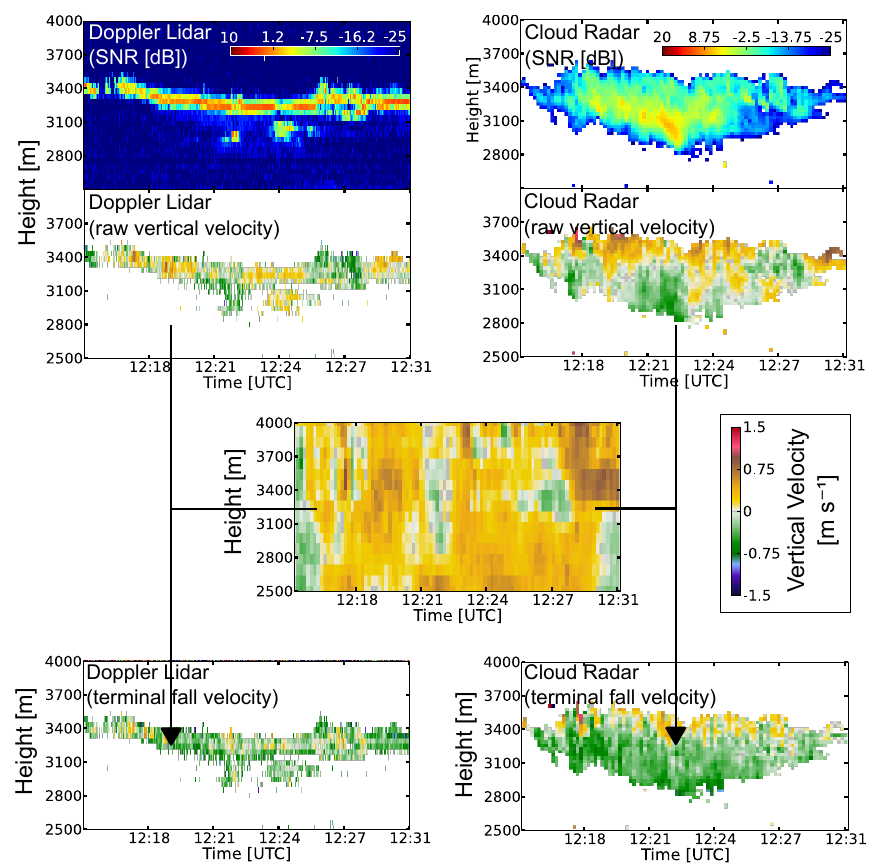
Figure 7. The vertical velocity of air measured by the wind profiler (center) is subtracted from the particle fall-velocities measured by Doppler lidar and cloud radar (top row). The resulting velocities (bottom row) are the terminal fall-velocity of the particles relative to the surrounding air. In the turbulent top layer, the turbulent motion is too fast and happens on scales which are too small to be correctly resolved by the wind profiler, resulting mostly in unrealistic upward velocities at the cloud top layer. Radiosonde data show a cloud-top temperature of − 3 ◦ C and a cloud-base temperature of 0 ◦